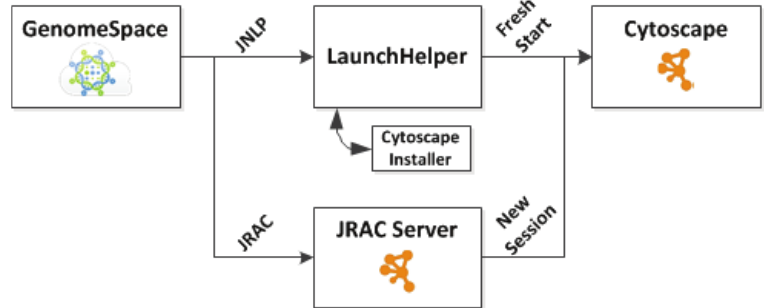
Figure 1. Launching Cytoscape from